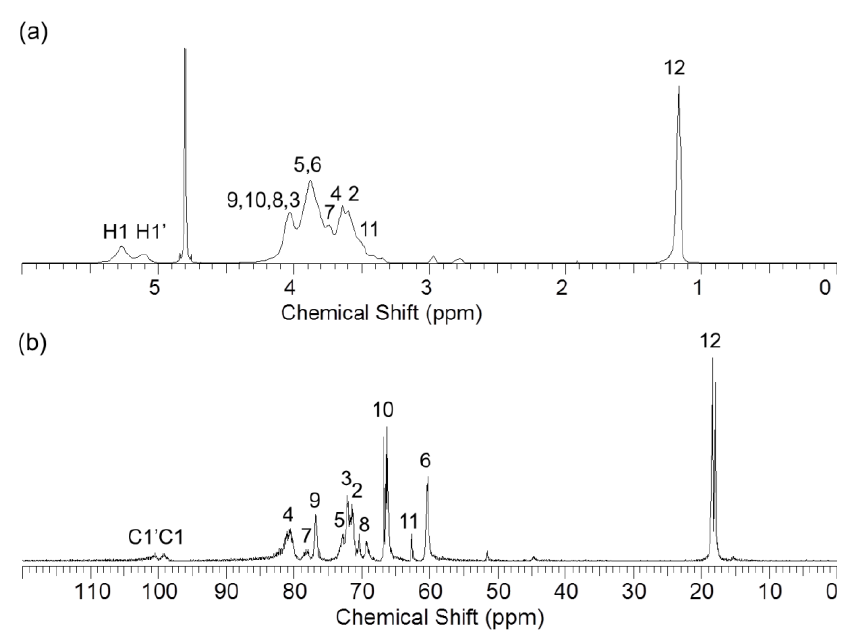
Figure 3. ( a ) 1 H NMR spectrum and ( b ) 13 C NMR spectrum of HP-β-CD-ol in D 2 O solvent.